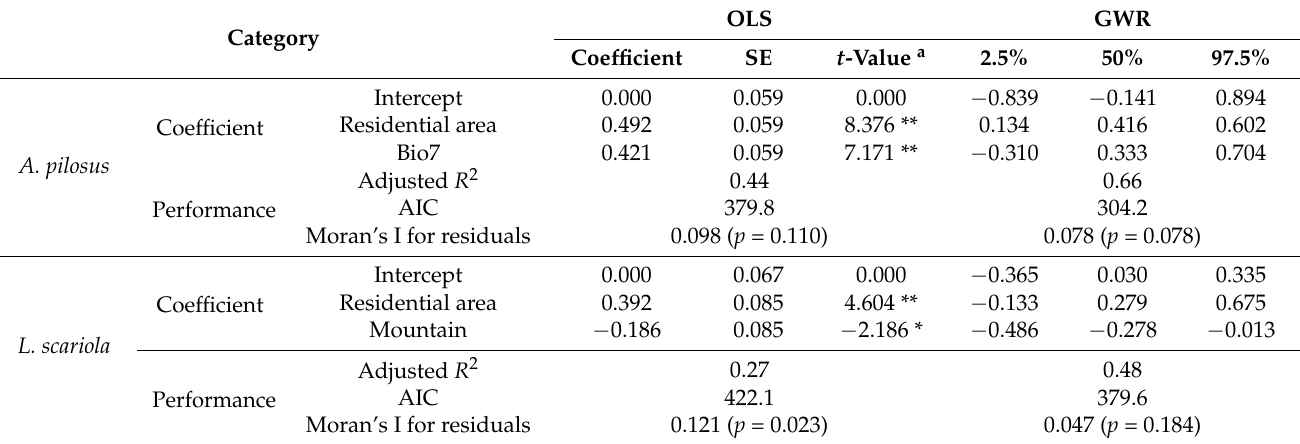
Figure 3. Partial least squares regression (PLSR) biplot of the first two components ( A ). Regression coefficient ( B ) and variable importance to the projection (VIP) ( C ) from the PLSR of L. scariola (Ls) density. The variables with VIP > 1 are good candidates to explain L. scariola density. Variable abbreviations are given in Figure 2. Table 1. Comparison between ordinary least squares (OLS) and geographically weighted regression (GWR) model